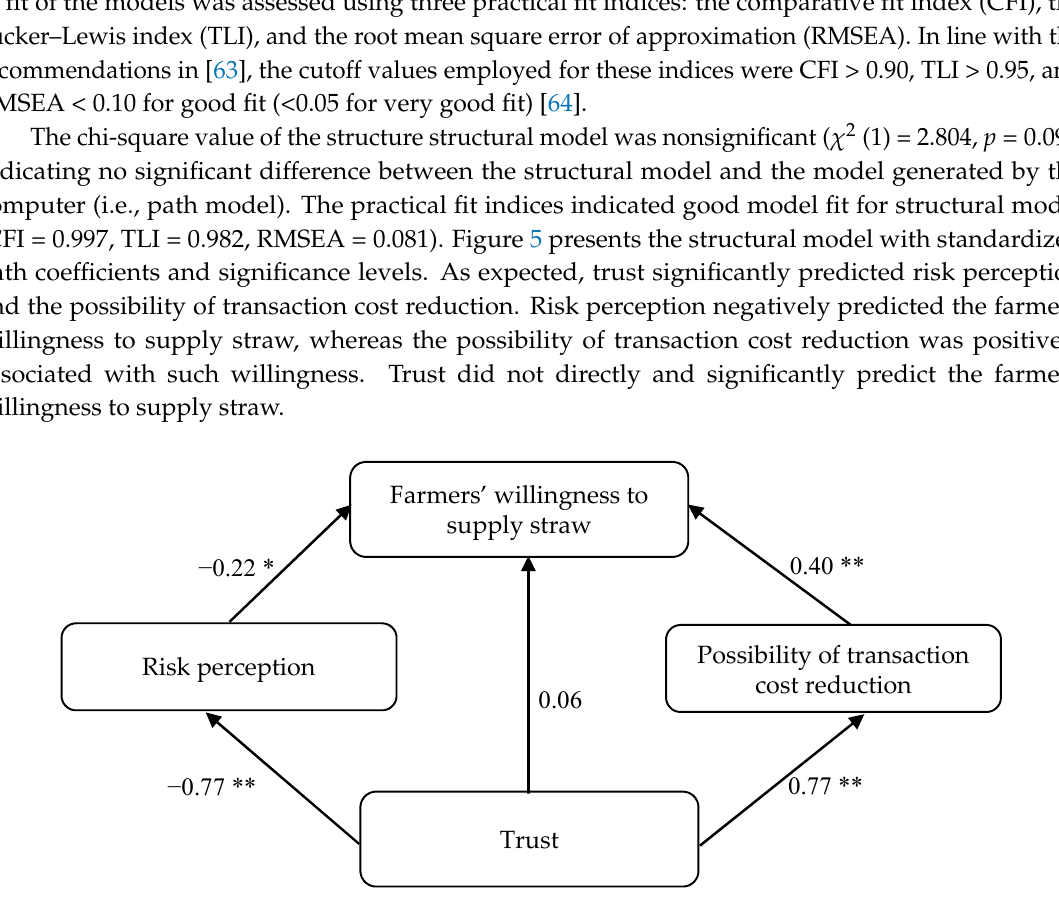
Figure 5. Structural model. Notes: (1) * p < 0.01, ** p < 0.001; (2) Numbers are standardized beta coefficients.